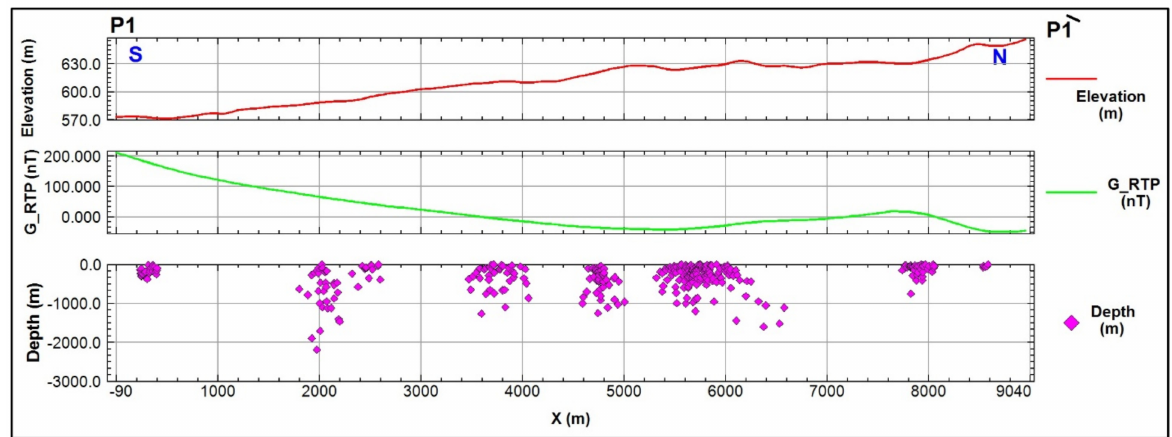
Figure 9. Analytical signal technique for aero magnetic profile (P1) of Homrit Waggat area, Central Eastern Desert,